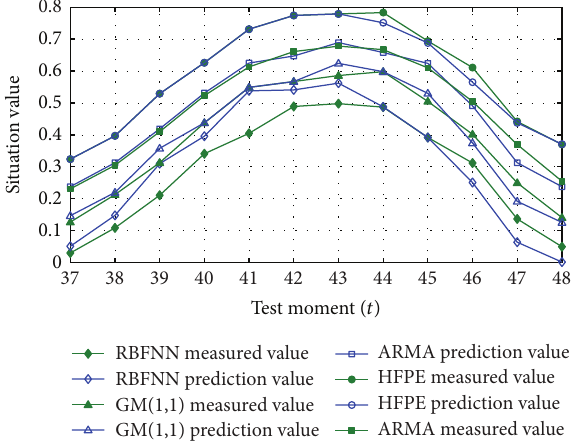
Figure 5: Prediction results of network attack situation.